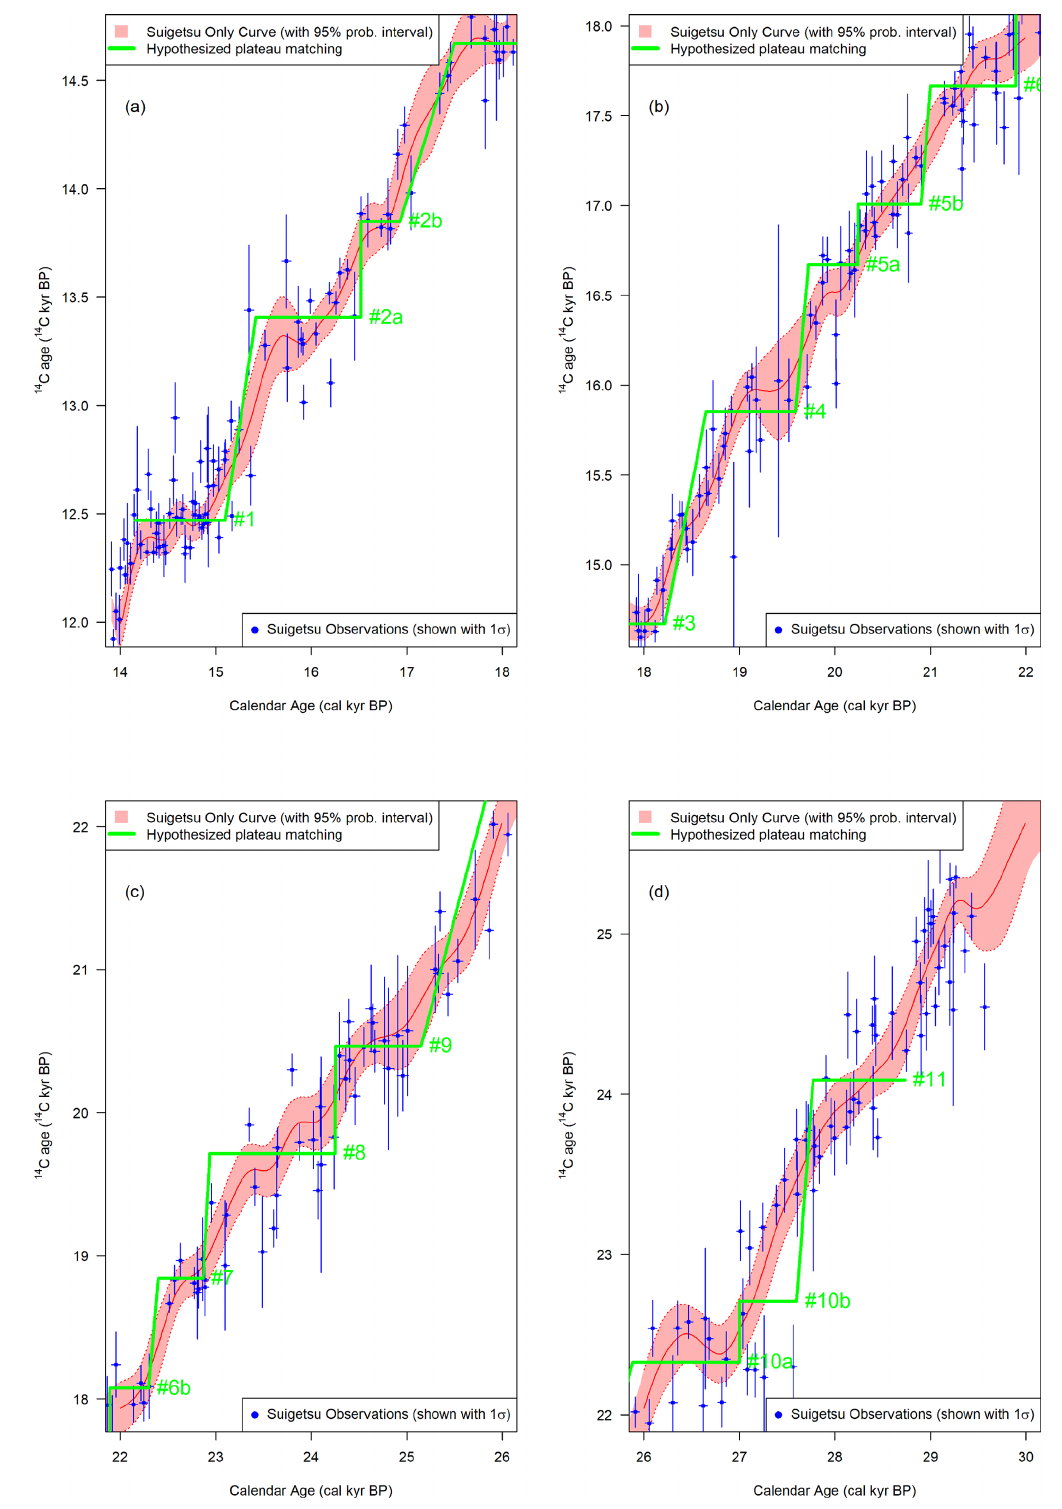
Figure 1. Blue dots show the Lake Suigetsu 14 C data with their 1 σ analytical uncertainties in both radiocarbon and calendar age (Bronk Ramsey et al., 2020). The thin solid red line shows the pointwise posterior mean of a radiocarbon calibration curve constructed using the same Bayesian statistical method as IntCal20 (Heaton et al., 2020b; Reimer et al., 2020) but based only on the Suigetsu 14 C data. The accompanying shaded interval represents the 95% posterior predictive probability interval. Superimposed thick green lines indicate the 15 atmospheric plateaus with their numbering as listed in Table 1 of Sarnthein et al.